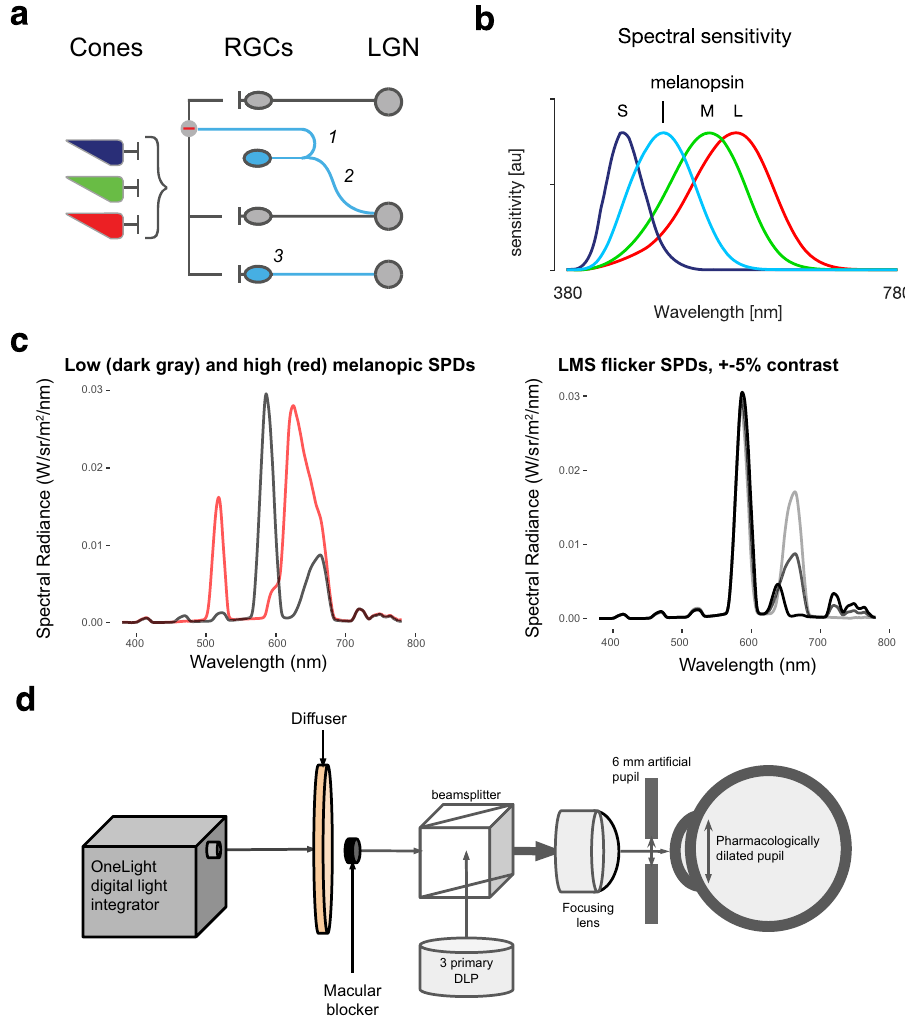
Figure 1. Theoretical background and experimental design. ( a ) Retinal wiring schematic. There are several hypothesized locations at which signals from the melanopsin-containing ipRGCs (blue) might interact with signals from the cones, which are predominantly conveyed by the classical RGCs (gray). (1) Recurrent axon collaterals from ipRGCs can provide inhibitory signaling on cone pathways; (2) ipRGCs can project to LGN cells that also receive inputs from the classical RGCs; and (3) cone and melanopsin signals may interact within the ipRGCs themselves. ( b ) Spectral sensitivities of the L, M and S cones and of the melanopsin-containing ipRGCs. Each sensitivity is normalized to a peak of unity. ( c ) Left: spectral radiance of the low- (dark gray) and high- (red) melanopic backgrounds. Right: example spectral modulations for LMS directed flicker. The dark gray line is the spectral radiance of the low-melanopic background (same as in the panel on the right). The black and light gray lines provide the spectral radiance of the low and high (± 5% contrast) arms of the LMS directed flicker around this background. ( d ) Apparatus schematic. Light produced by the digital light integrator was passed through a randomized optical fiber and lens assembly (not shown) and was imaged on a diffuser, to produce a spatially uniform field. Light from a 3 primary DLP projector was optically admixed through a beam splitter with the light from the digital light synthesizer (lenses and neutral density filters not shown). The participant viewed the combined stimulus through a lens, such that the diffuser subtended 27.5° (diameter), with the central 5° (diameter) macular region